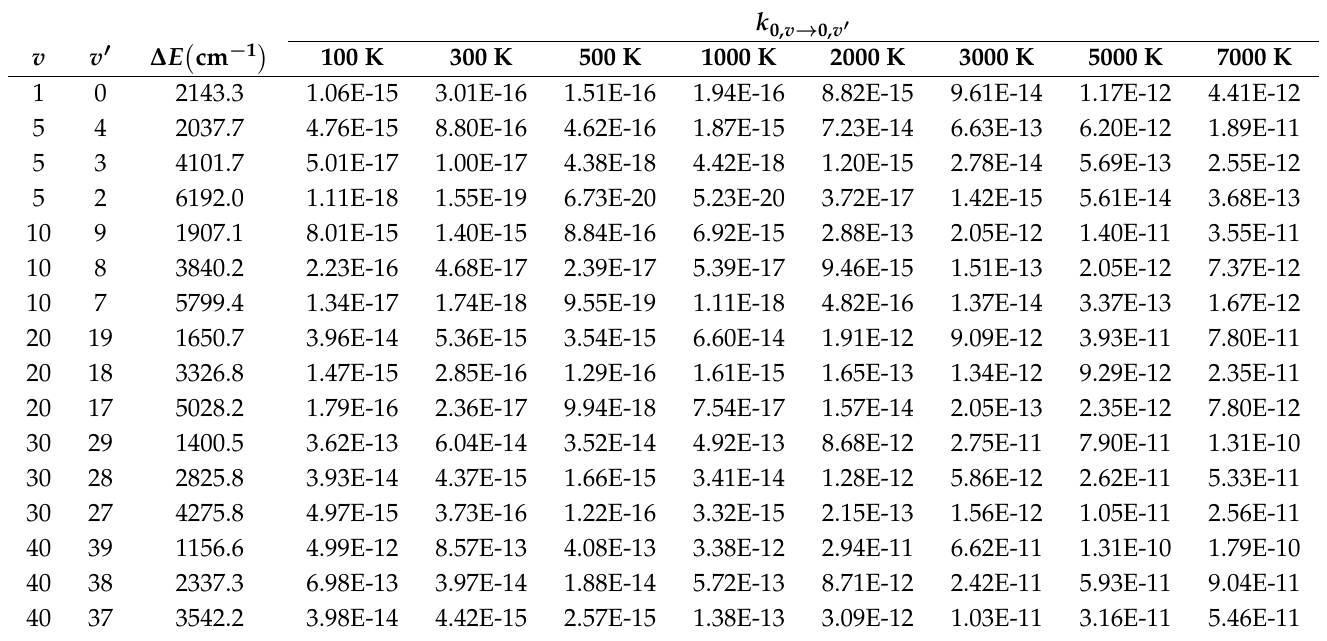
Table 14. Multiquantum V–T/R rate coefficients (in cm 3 /s) for the transition CO ( v ) + N 2 ( 1 ) → CO ( v (cid:48) ) + N 2 ( 1 ) + ∆ E